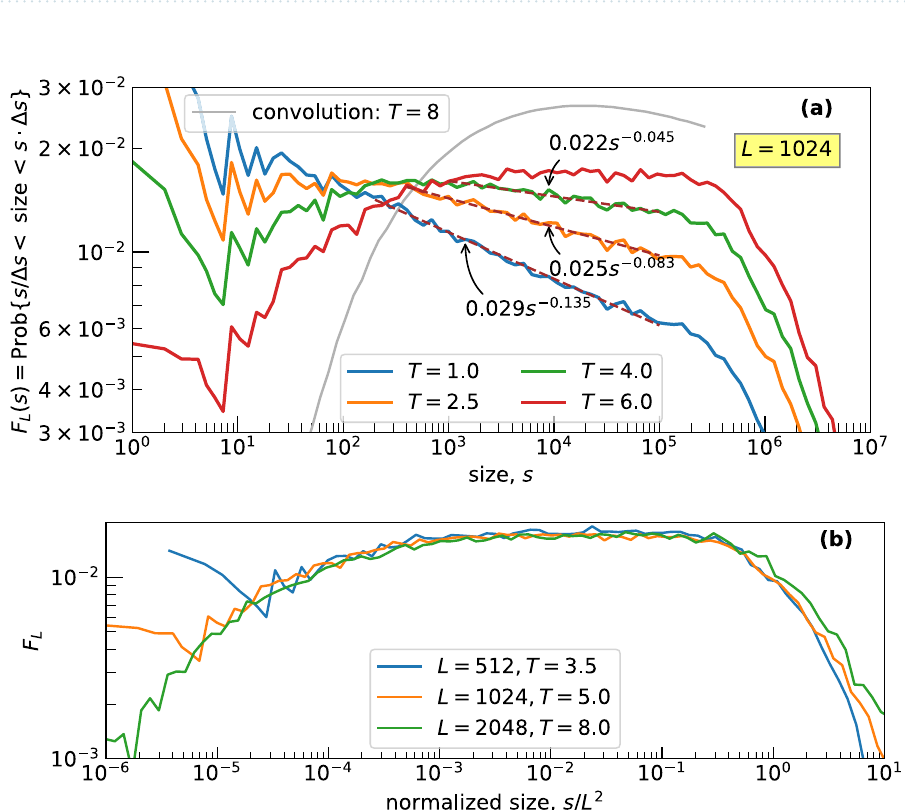
Figure 3. Size-frequency relation F L ( s ) : BTW model, where the mega-avalanches are obtained through merging of the standard avalanches occurred within T consecutive time moments. ( a ) L is constant; the gray 1.20 curve is obtained through the convolution of 8 probability densities ∼ s − with the support [1, 1024]. ( b ) L is 2 variable; the sizes are normalized by L to collapse F L ( s ) with adjusted T